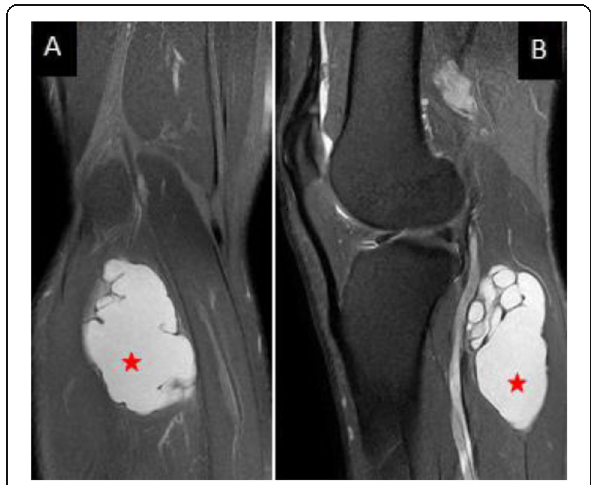
Fig. 3 Thirty-year-old male with lymphangioma in the proximal leg along the posterior aspect. Findings: coronal ( a ) and sagittal ( b ) STIR images. The lesion shows a high signal (red asterisk). Adjacent muscle show normal signal, suggestive of a lack of perilesional inflammation. Technique: Philips Insta 1.5-T MRI — STIR coronal and sagittal: TR 3762 ms, TE 80 ms, TI 150 ms, matrix 240 × 168 and